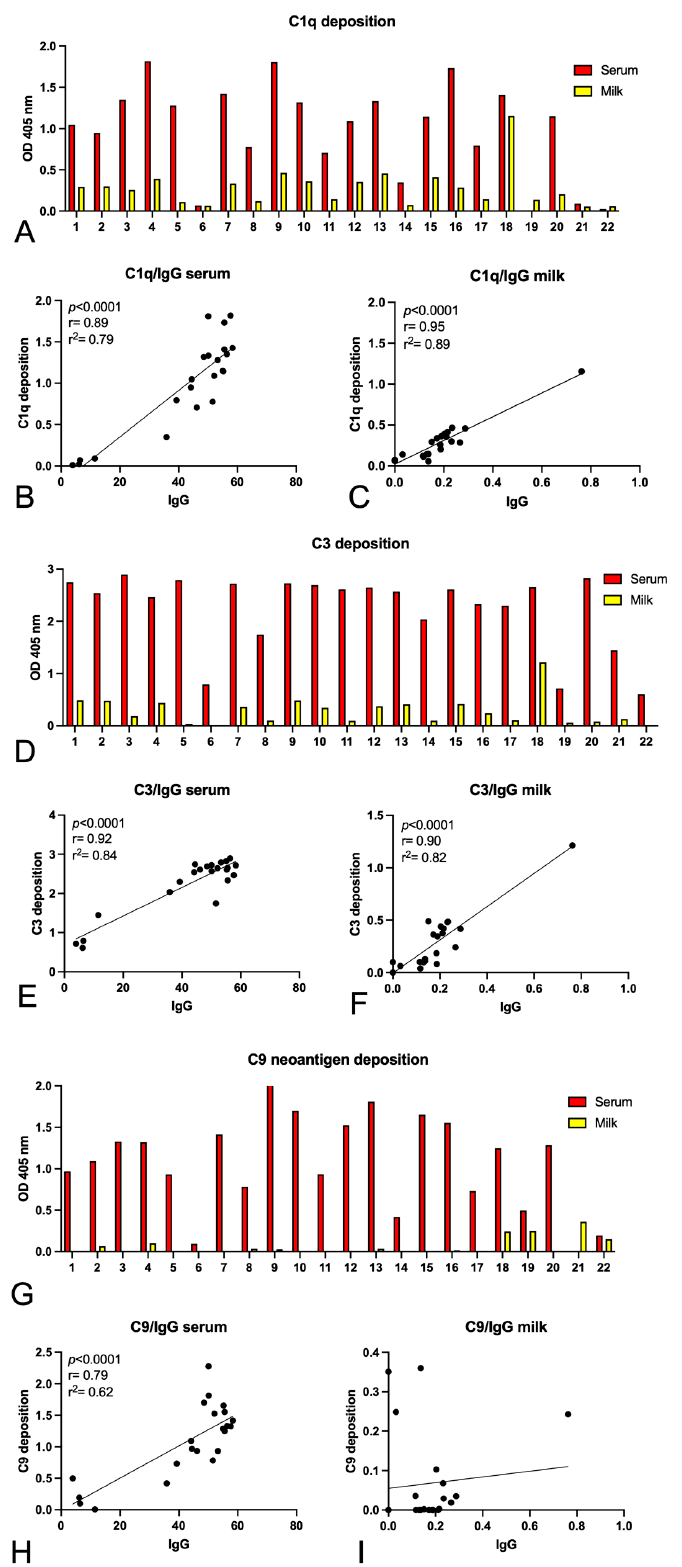
Figure 3. Complement activation by anti-S Igs present in the serum and the milk of vaccinated women. C-system activation by anti-S Igs of serum and milk was evaluated by ELISA for the detection of C1q ( A – C ), C3 ( D – F ), and C9 neoantigen deposition ( G – I ).